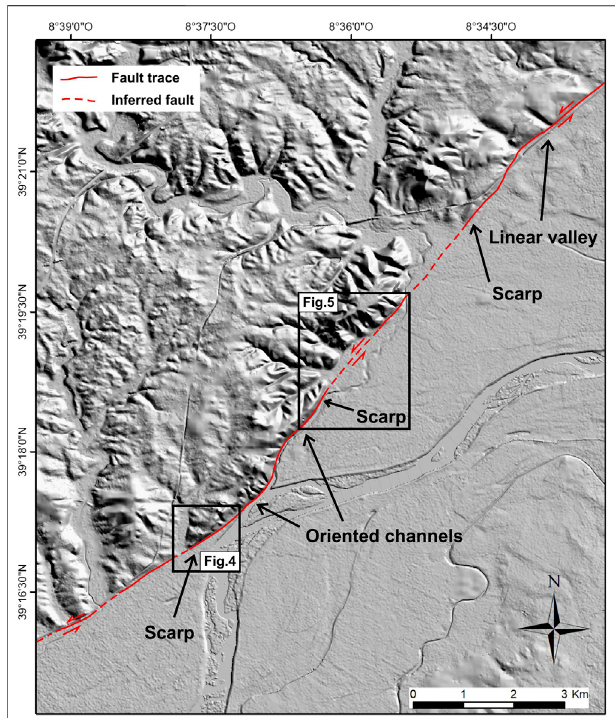
FIGURE 3 | Fault trace and fault-related features over the 0.5 m- resolution DEM. The locations of Figure 4 and Figure 5 are outlined with